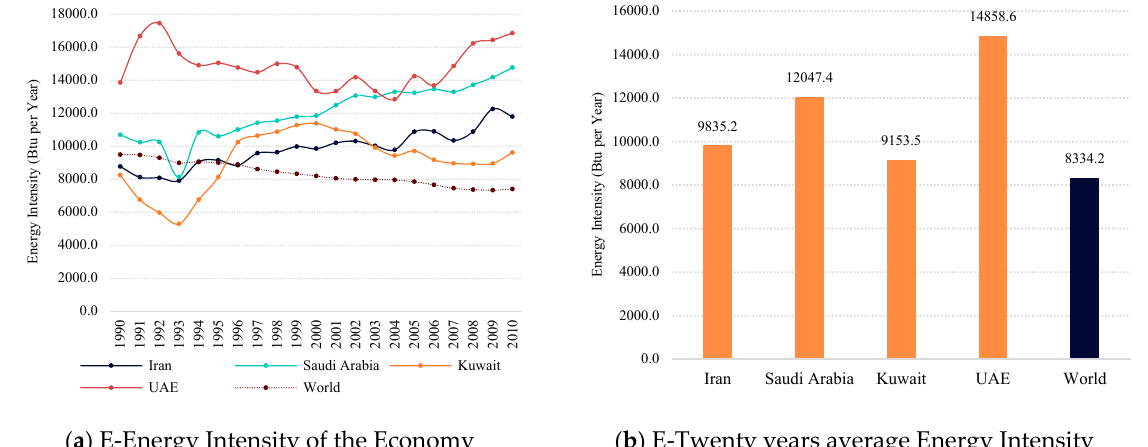
Figure 9. (a ) Economic indicator for STEEP (Energy Intensity); ( b ) Environmental indicator (carbon emission intensity).